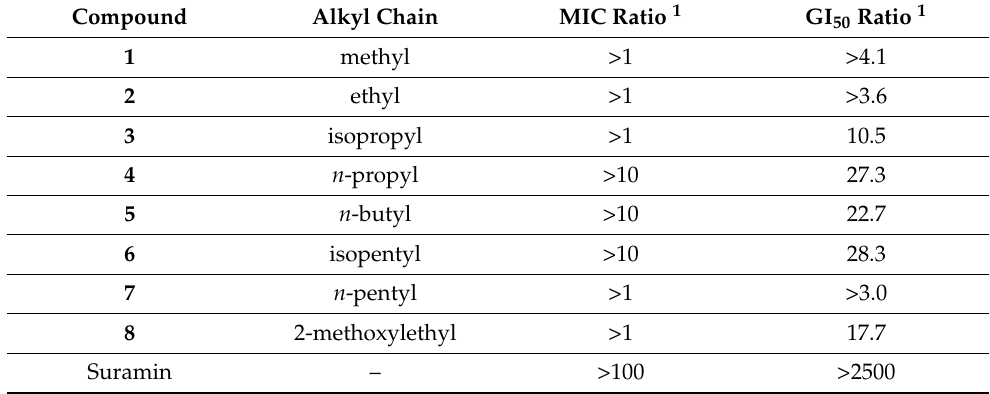
Table 3. MIC and GI 50 ratios of cytotoxicity to trypanocidal